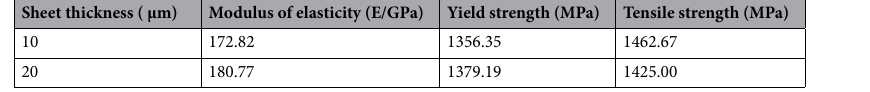
Sheet thickness ( μm)